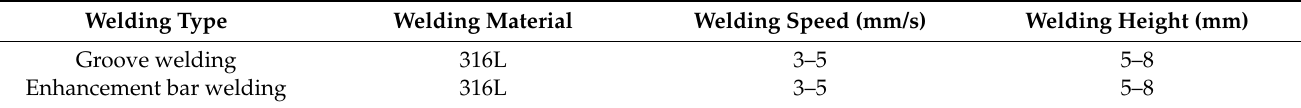
Figure 14. Schematic of the rebar bar welding. Table 8. Welding process parameters for rebar. Table 8. Welding process parameters for rebar.